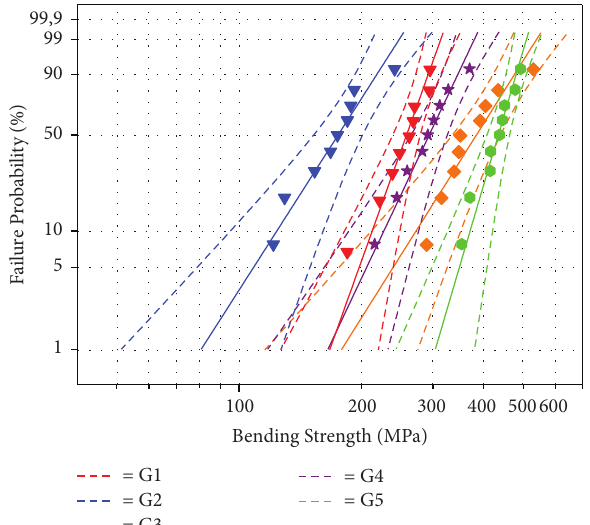
Figure 4: Weibull probability plot of the flexural strength of lithium disilicate